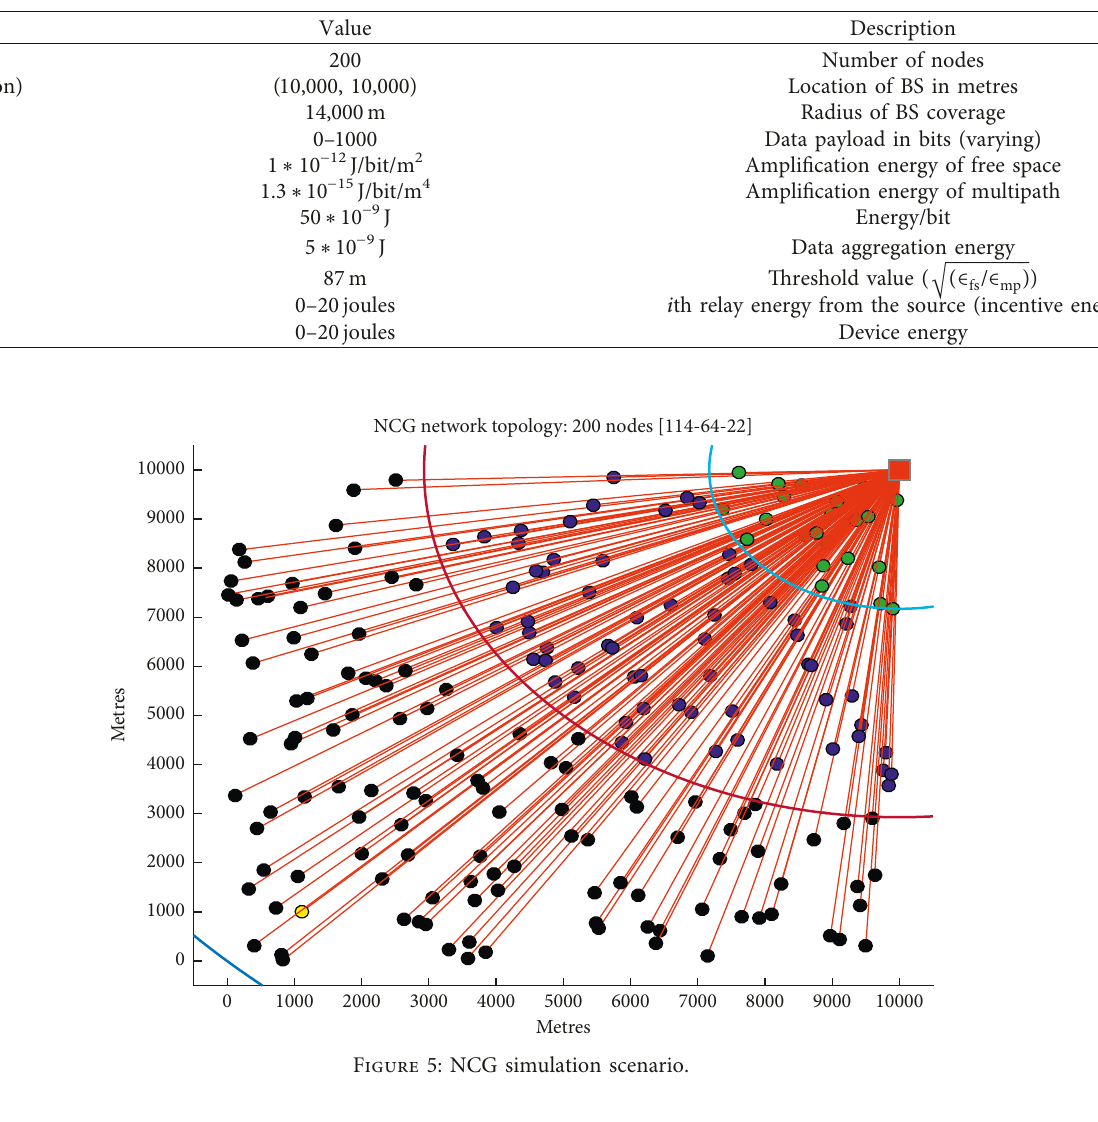
Table 1: Simulation